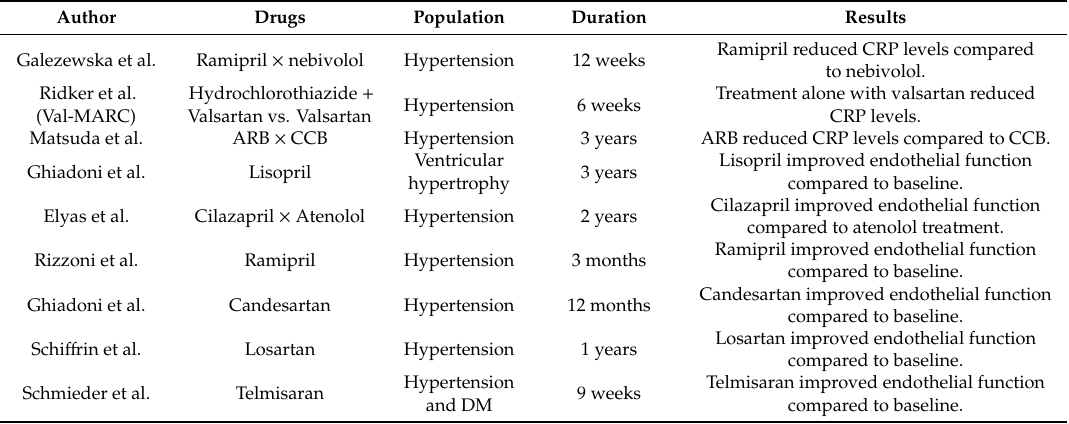
Table 1. Randomized clinical trials showing the e ff ect of treatment with angiotensin converting enzyme inhibitors (ACEI) and angiotensin II receptor blockers (ARBs) on serum C-reactive protein levels and endothelial